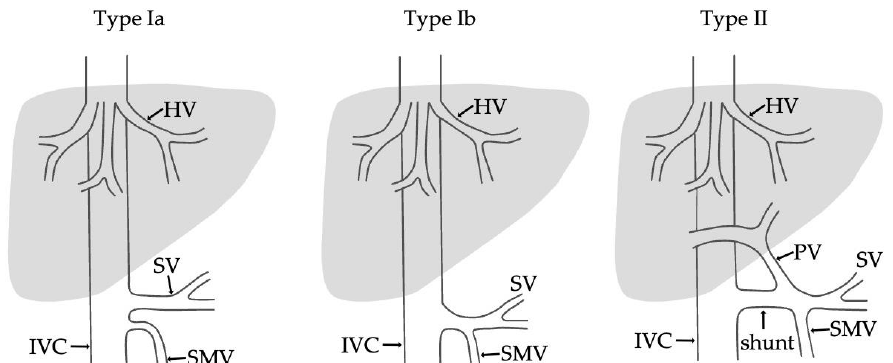
Figure 1. Classification of Abernethy malformation according to Morgan and Superina. IVC—inferior vena cava; SMV—superior mesenteric vein; SV—splenic vein; HV—hepatic veins; PV—portal vein.